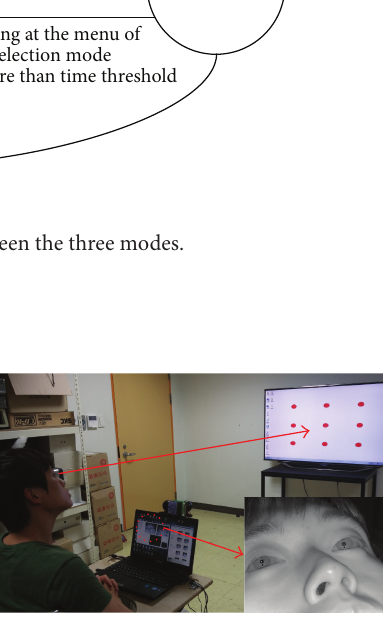
Figure 26: Example of operation of the proposed system with the user imitating involuntary head movement.